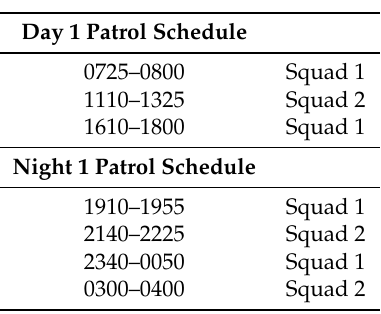
Table 3. Example patrol schedule.